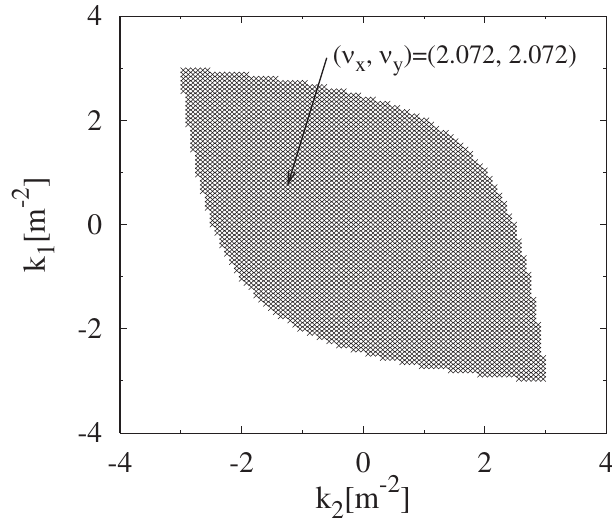
FIG. 2. Stable region of the linear betatron oscillation. The field gradient of two quadrupole magnets k as the parameter. The minus sign of the field gradient means that the quadrupole magnet has a defocusing effect in the horizontal direction. The tune values at the operating point (cid:4) k (cid:4) 0 : 78 (cid:9) m (cid:1) 2 (cid:10) ; (cid:1) 1 : 24 (cid:9) m (cid:1) 2 (cid:10)(cid:5) are (cid:4) (cid:5)